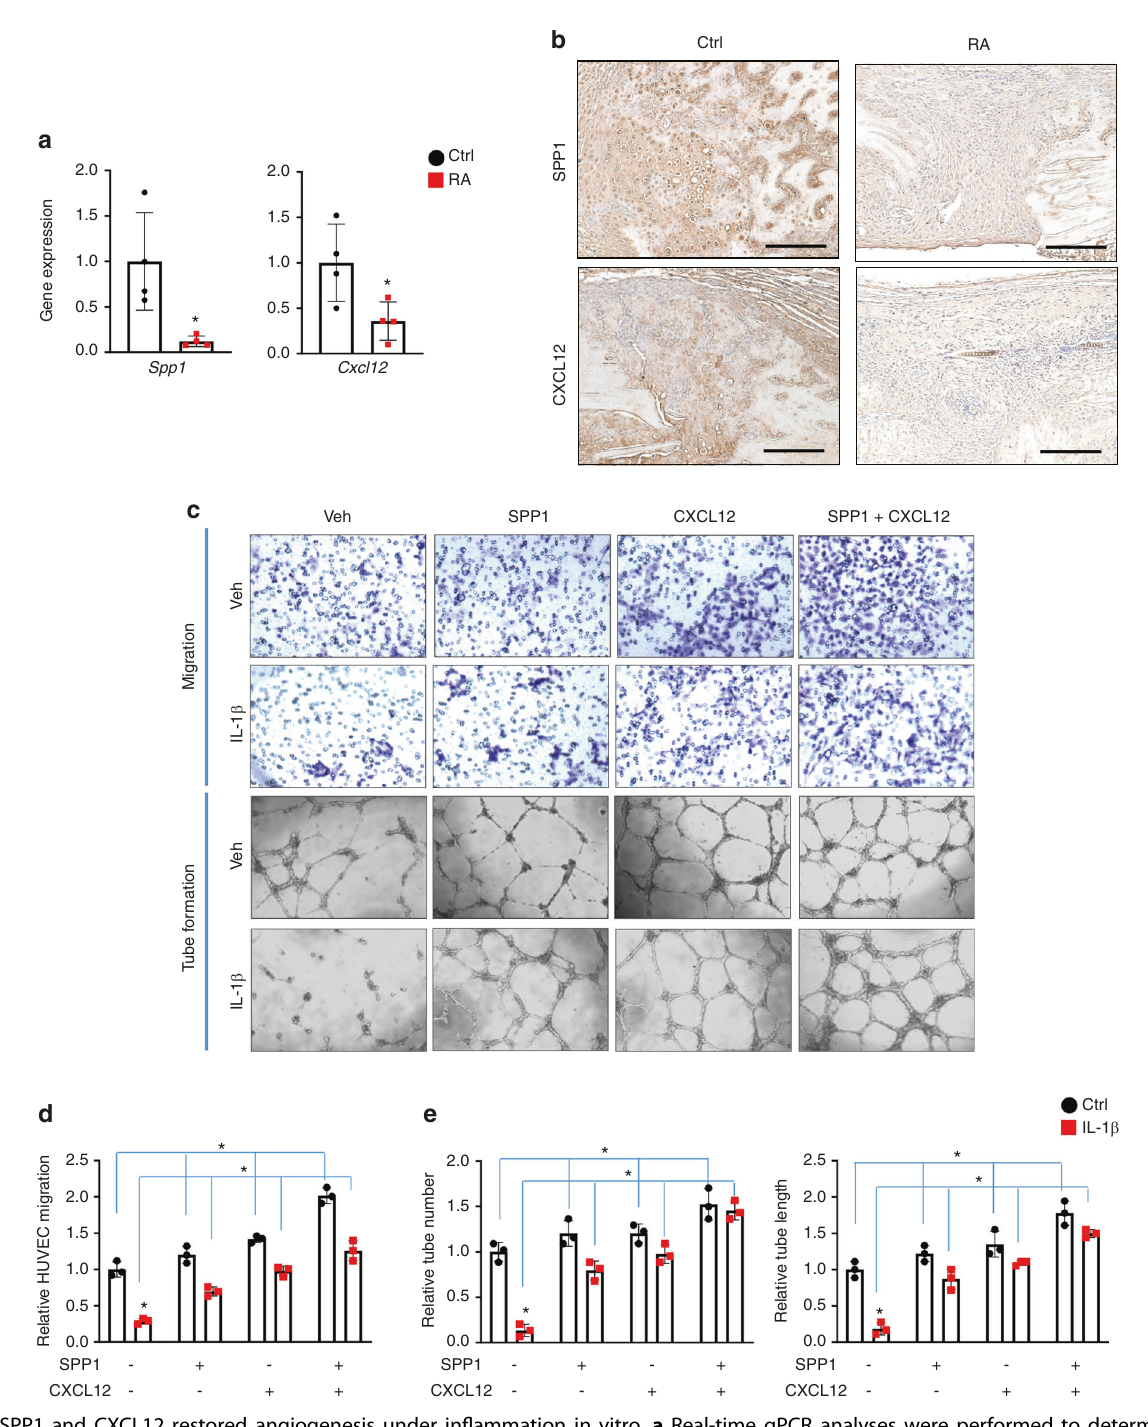
Fig. 3 SPP1 and CXCL12 restored angiogenesis under in fl ammation in vitro. a Real-time qPCR analyses were performed to determine the relative expression of Spp1 and Cxcl12 in 10 dpf fracture calluses from control and RA mice ( n = 4). The mRNA levels were normalized to that of Actb and then normalized to the control group. * P < 0.05 compared with control by Student ’ s t test. b Immunohistochemical staining of 10 dpf fracture calluses from control and RA mice for SPP1 and CXCL12. c Representative images from HUVEC migration and tube formation assays using culture medium from vehicle- and IL-1 β -treated chondrocytes supplemented with SPP1 and CXCL12, respectively. Quanti fi cation of ( d ) HUVEC migration as well as ( e ) tube number and tube length ( n = 3). All results were normalized to the controls. * P < 0.05 compared with control by two-way ANOVA. Scale bar, 200 μ scaffolds, i.e., by simultaneously electrospinning PCL fi bers and tions, to deliver SPP1 and CXCL12 locally. 62 We used our unique electrospinning and electrospraying system 63 to fabricate PCL (Fig. 4a). To demonstrate the core – shell structured microspheres,